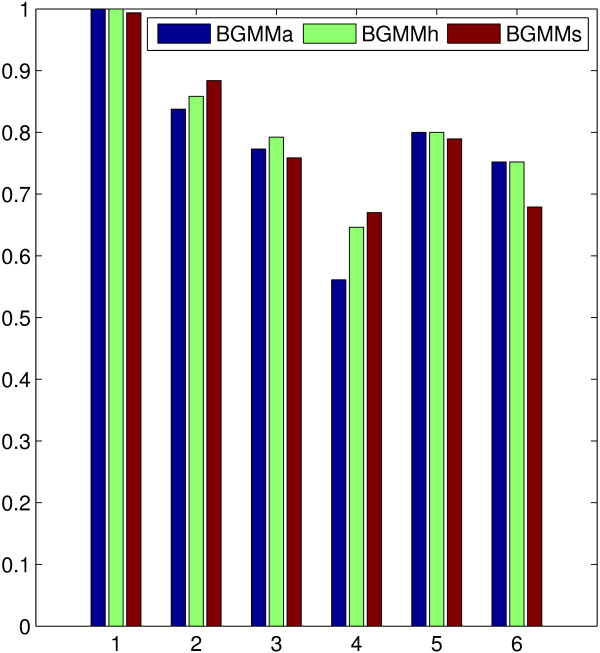
Comparison of the E score among BGMMa, BGMMh and BGMMs. x-axis corresponds to the different combinations of the tested scenarios: 1:gB+gG, 2:bB+gG, 3:gB+bGm, 4:bB+bGm, 5:gB+bGv, 6:bB+bGv.